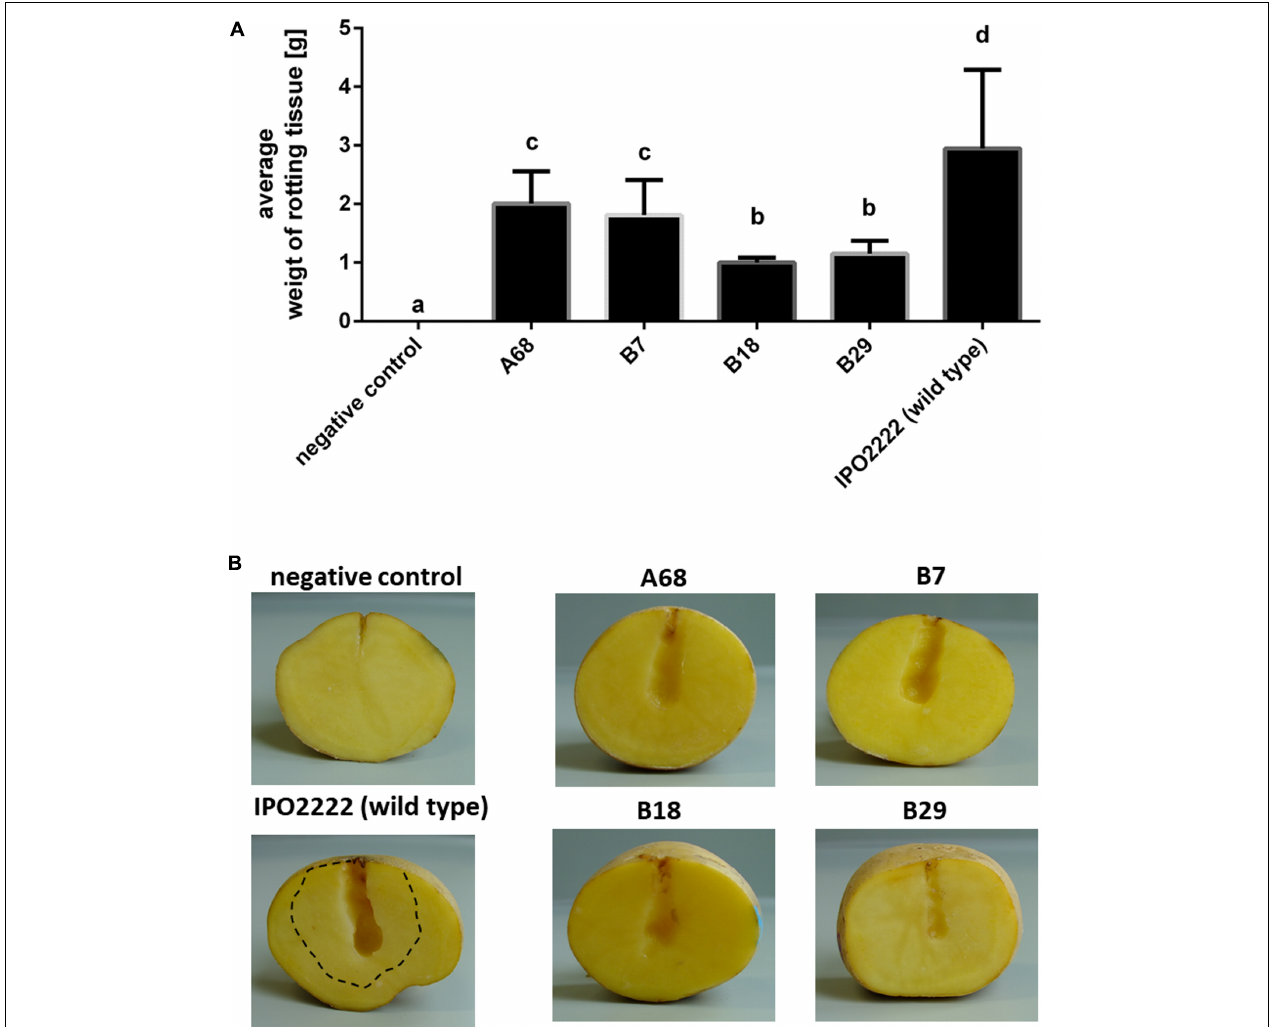
FIGURE 2 | Ability of four Dickeya solani IPO2222 Tn5 mutants to cause maceration (rotting) of potato tuber tissue. Quantitative determination of average weight of rotting tuber tissue (in grams) collected after 72 h incubation at 28 ◦ C in a humid box. Per mutant, ten individual potato tubers were inoculated in two independent experiments ( n = 20). Results were considered to be significant at p = 0.05 and pair-wise differences were obtained using the t -test. Error bars represent standard deviation (SD) (A) and visual estimation of symptom expression in potato tubers inoculated with individual IPO2222 Tn5 mutants or wild type (IPO2222, control) in Ringer’s buffer (Merck) after 72 h incubation in a humid box (B) . Dotted line in (B) shows extent of tissue maceration – softening of plant tissue by the wild type IPO2222